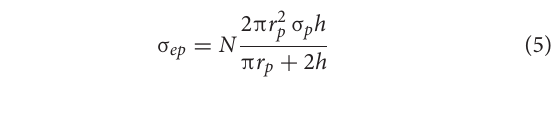
TABLE 2 | Parameters used in the asymptotic equation of the pore formation (DeBruin and Krassowska, 1999). Parameter Value